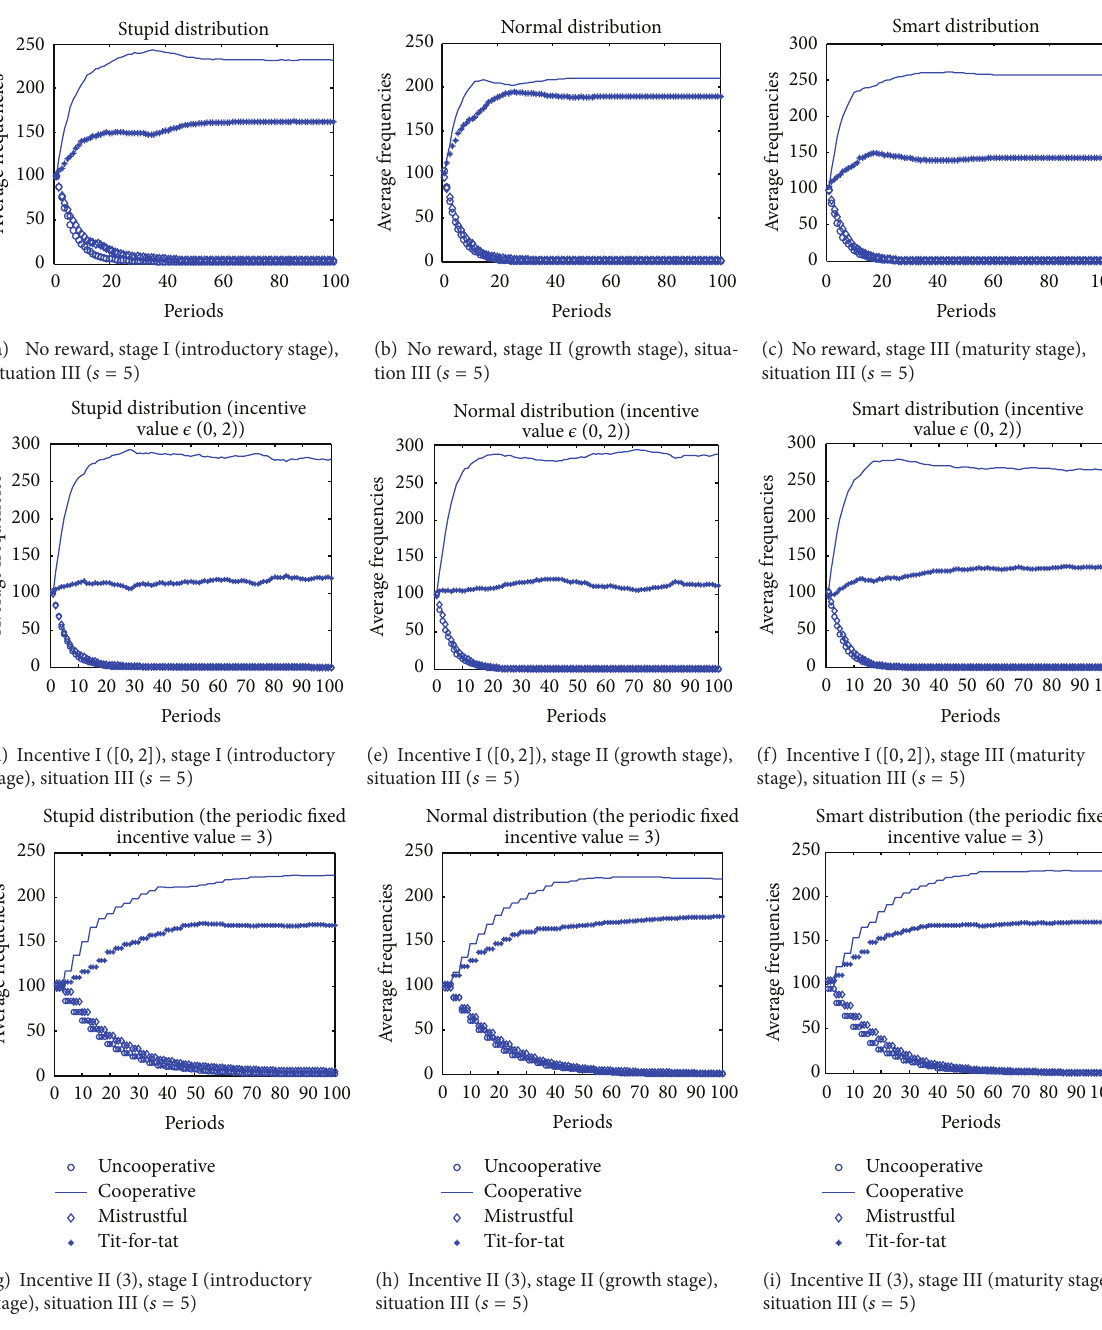
Figure 3: Dynamics about agents’ strategy change in different stages in situation III of